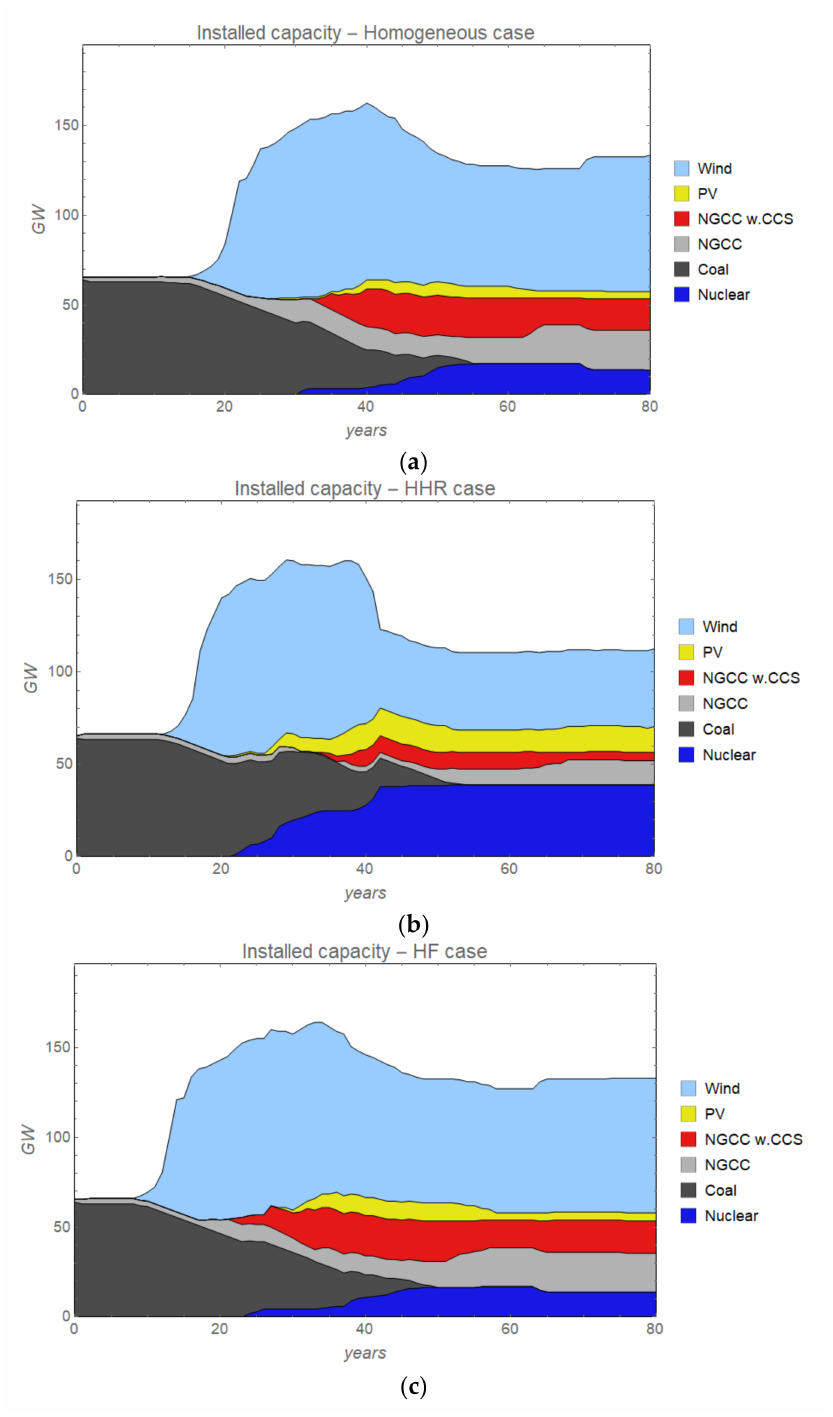
Figure 1. Installed capacity in the ( a ) homogeneous case, ( b ) HHR case, and ( c ) HF case. In all three cases, the capacity mix goes from coal-based to low-carbon, but the transition speed and final mix